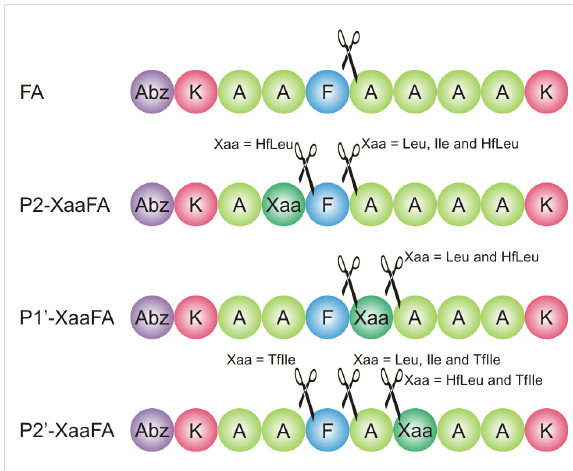
Figure 5: Cleavage positions for digestion of the different peptides with pepsin.